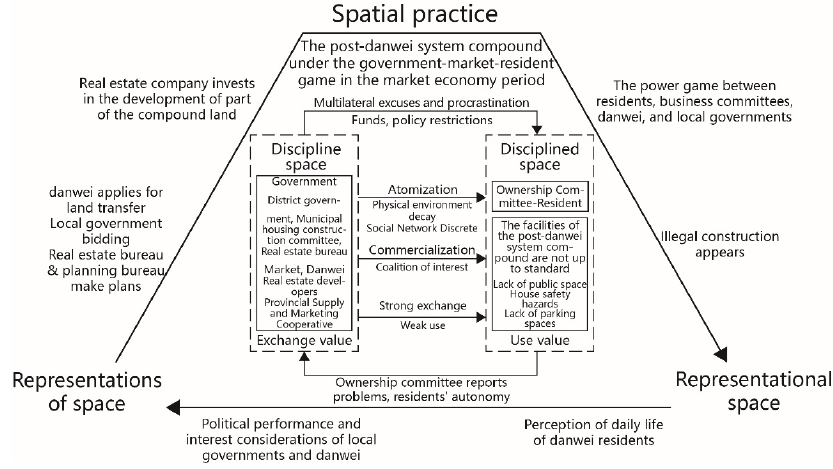
Figure 3. Atomic abstract space production path (source: self-drawn by one of the authors).